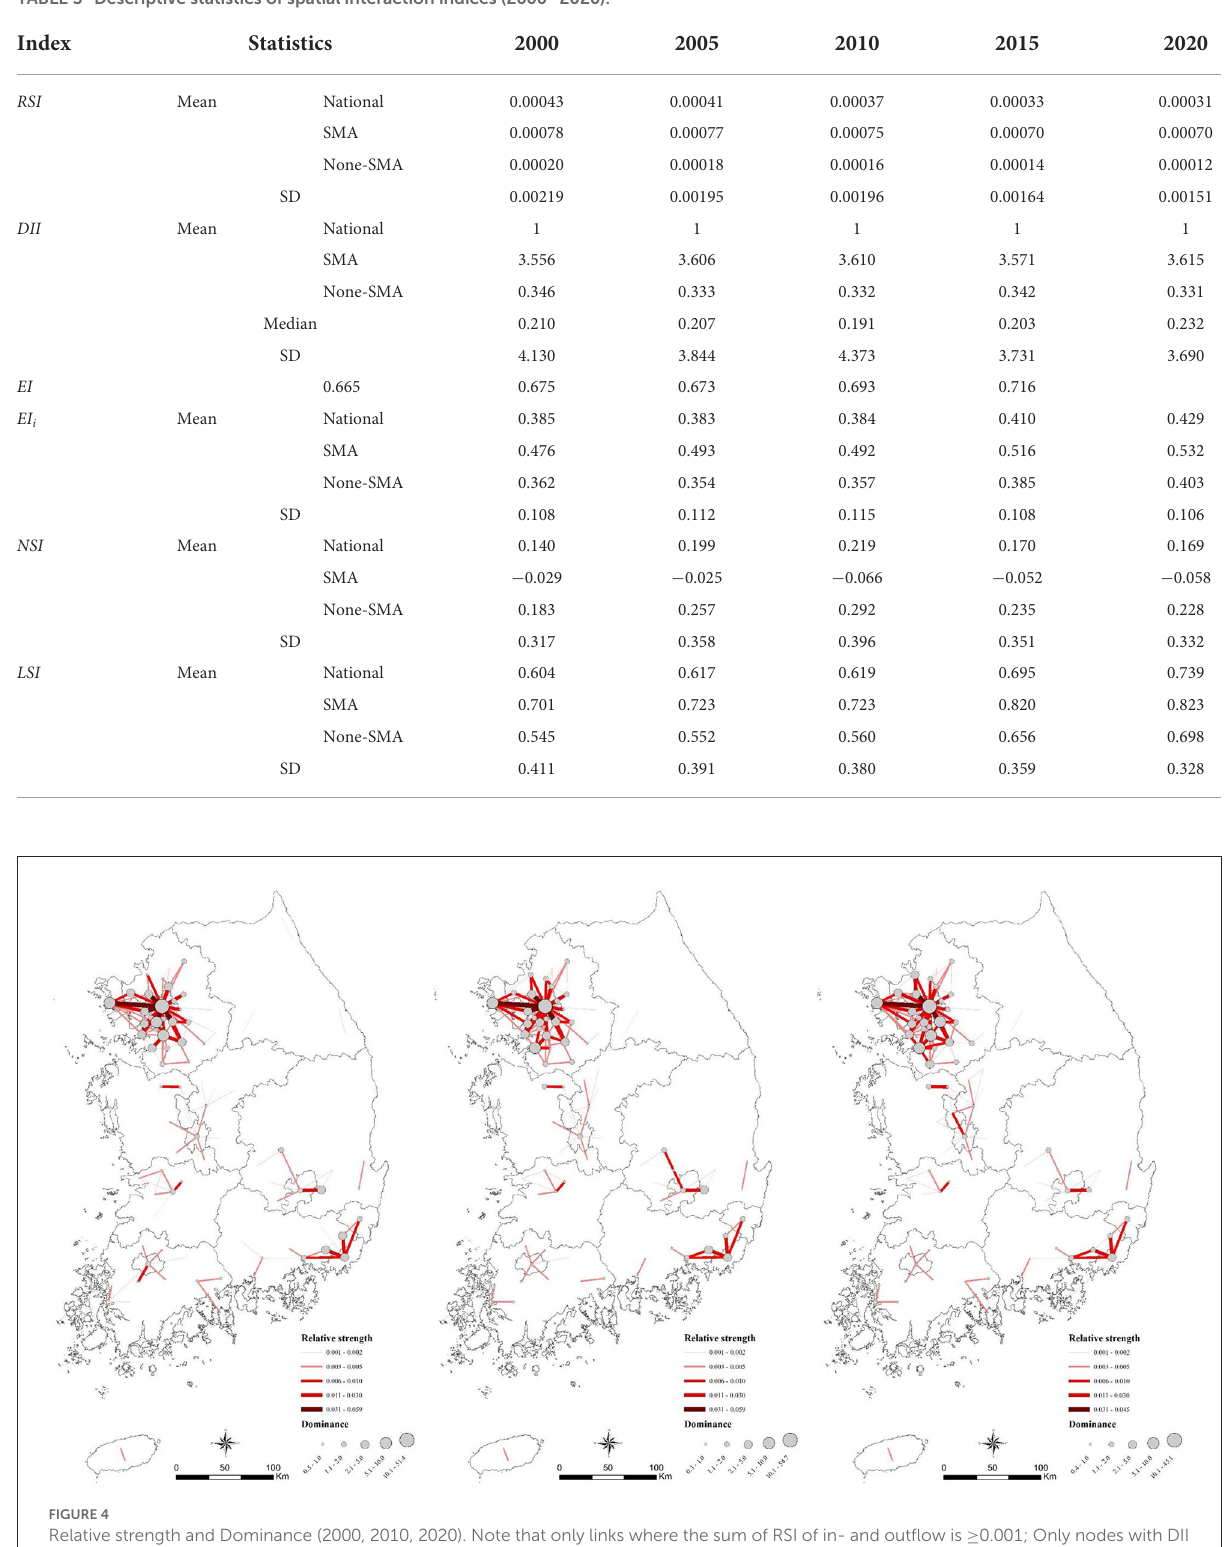
TABLE 3 Descriptive statistics of spatial interaction indices (2000–2020).